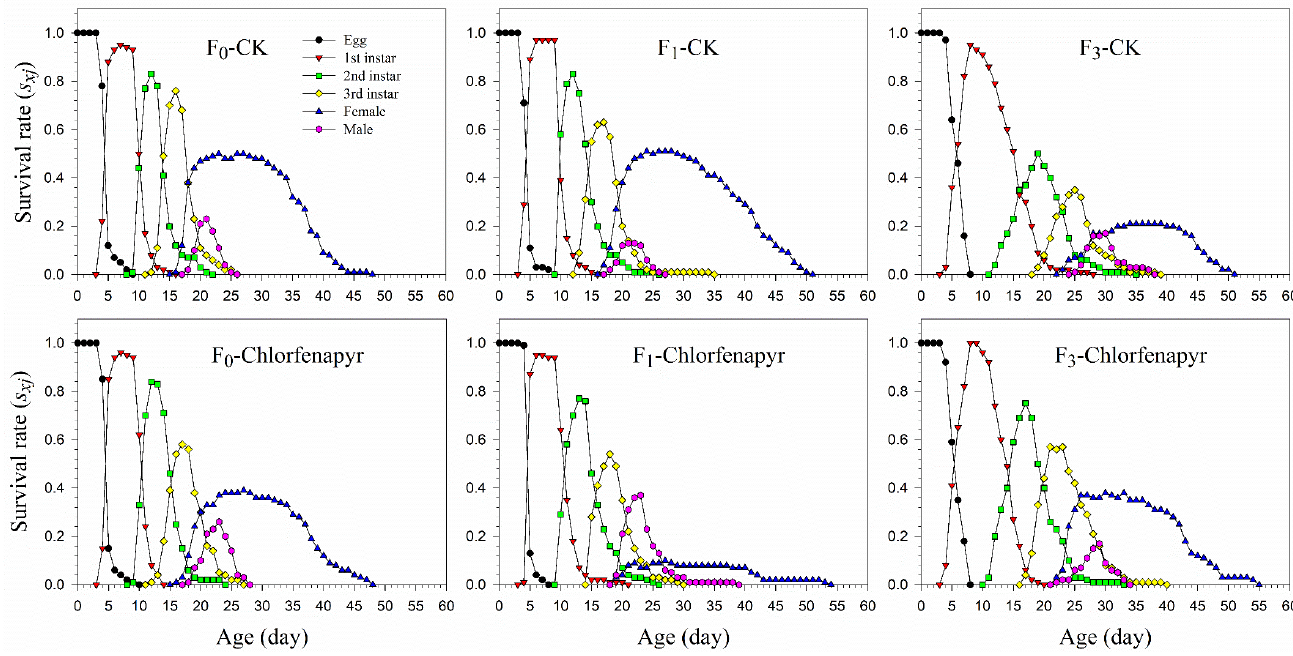
Figure 1. Age-stage-specific survival rate ( s xj ) of P . marginatus (F 0 , F 1 , and F 3 ) exposed to LC 30 of chlorfenapyr. CK represents the control.